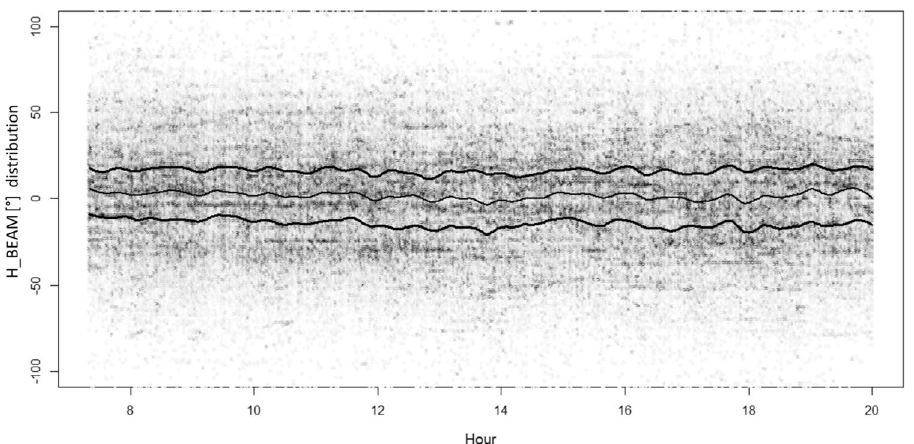
Figure 9. Angular distribution of measures around the direction of maximum power for cells not Sun oriented during July 2nd. Lines identify the distribution median (the central line) and +/− standard deviation deviation (color saturation reflects the density of